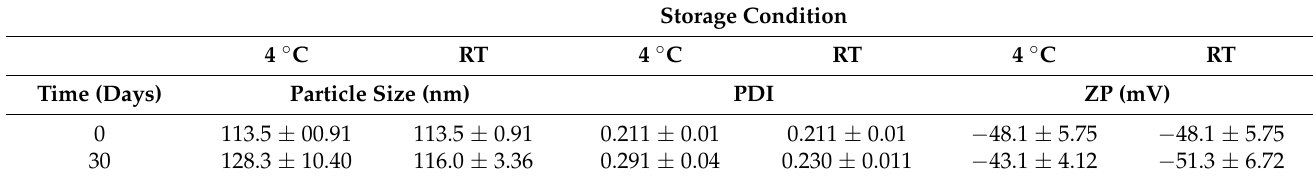
Table 4. Effect of storage on particle size, PDI, and ZP of nicotine−stearic acid conjugate SLNs at 4 °C and RT.